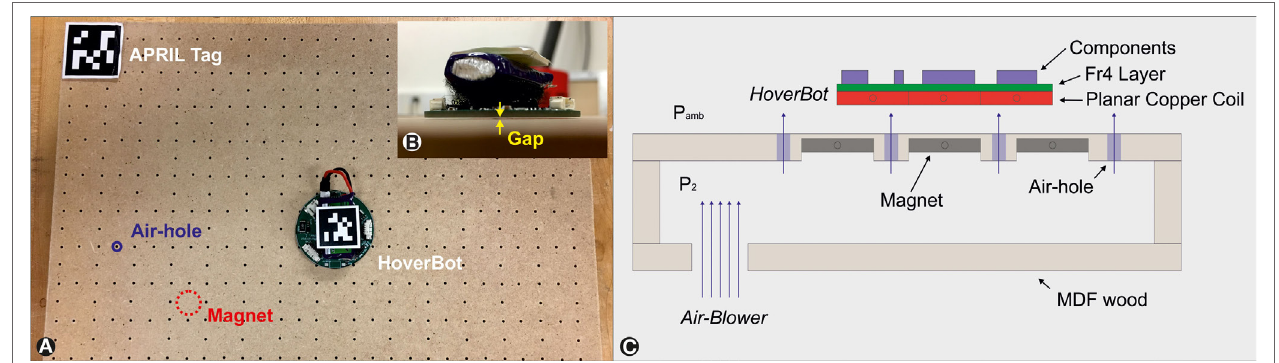
FigUre 1 | (a) Levitation–magnet table with a HoverBot on top. There are four AprilTags for each of the table corners (one visible in the figure) and one AprilTag attached to the HoverBot. The AprilTags are used for tracking (Olson, 2011). (B) A photograph showing an air gap between a HoverBot and the table.